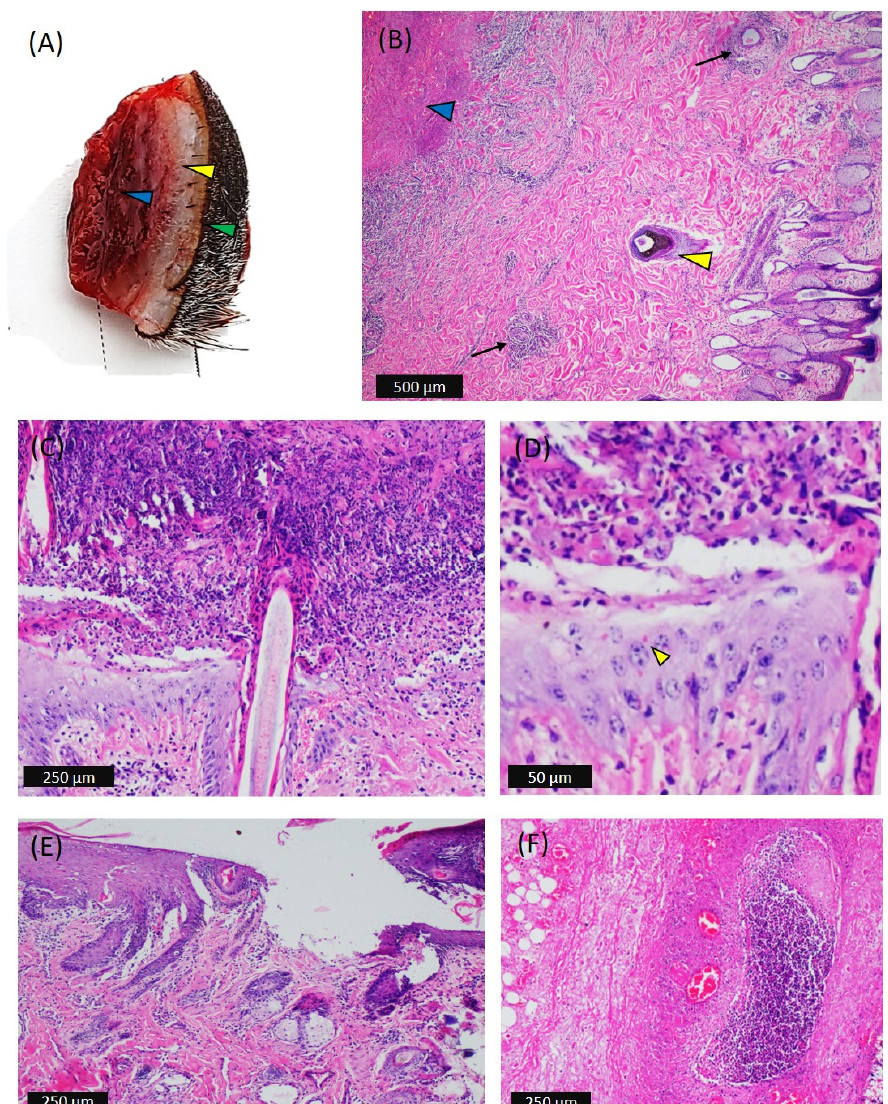
Figure 3. Gross and microscopic pathology of the skin nodules in affected cattle. ( A ) Biopsy of a skin nodule that was 2 cm in diameter that provided gritty sound when cut and showed hemorrhagic subcutis (blue arrowhead), pale dermis (yellow arrowhead), and haired epidermis (green arrowhead). ( B ) Epidermis: epidermal cytoplasmic swelling and mononuclear infiltrate. Dermis: diffuse proliferation of mononuclear cells between the dense irregular connective tissue and reticular layers and in the perivascular space (black arrow). Sweat and sebaceous glands were found dilated, and there was intracellular edema of sebaceous gland cells. The hair follicle matrix epithelia were found to be highly hyperplastic (yellow arrowhead). Subcutis: presence of an infarct (blue arrowhead). ( C ) Epidermis and dermis: vacuolation, swelling, and adhesion of scabs with proliferative stratum basale, intraepidermal necrosis, and accumulation of scale crust leaving ulcer underneath; in addition, the dermis was hemorrhagic, edematous, and infiltrated with mononuclear cells. ( D ) Occasionally, keratinocytes were consistent with intracytoplasmic inclusion bodies (yellow arrowhead). ( E ) Vacuolation and swelling of keratinocytes, epidermal proliferation of basal cells, infiltration of round histiocytic cells in the reticular layer of skin, swelling, and vacuolation of glandular epithelium and focal ulceration. ( F ) Subcutis: presence of focal aggression of mononuclear cells, congestion, necrosis, and lysis of subcutaneous fat cells.